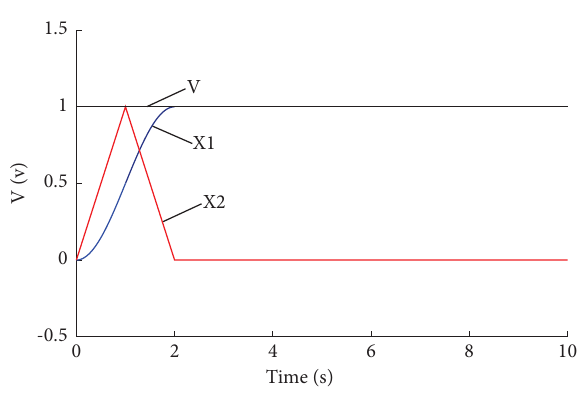
Figure 5: Characteristics of the diferentiator.